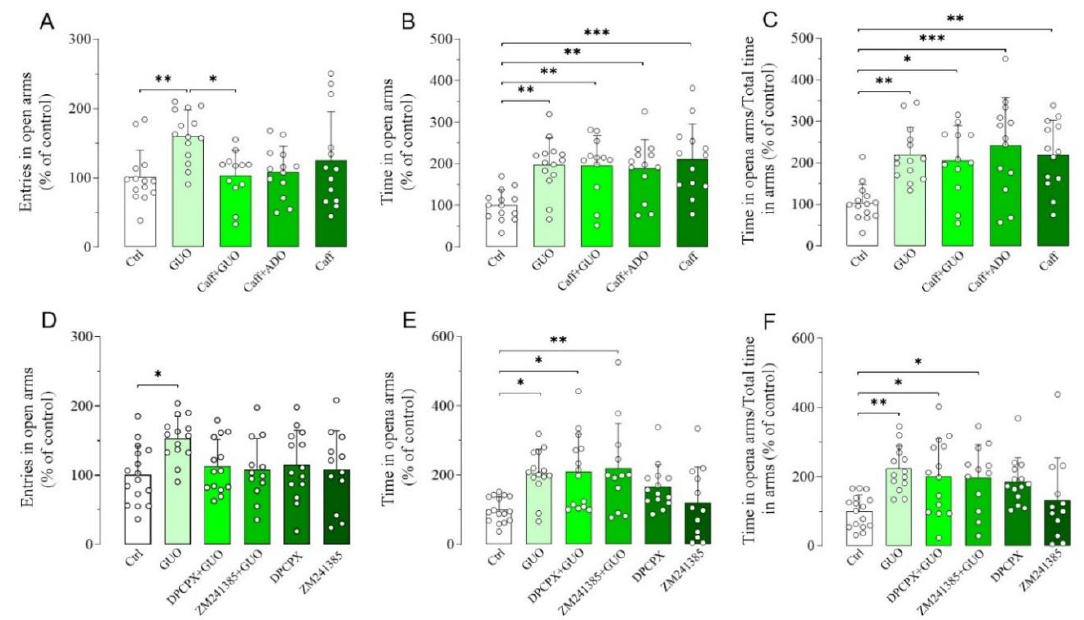
Figure 3. Effects of A 1 R and A 2A R antagonists on anxiolytic-like effect of GUO evaluated by EPM test during a 5 min session. ( A – C ) Functional competition between GUO and nonselective ARs antagonist caffeine (Caff). Caffeine alone (30 mg/kg) induced anxiolytic effects, as shown by significant increase